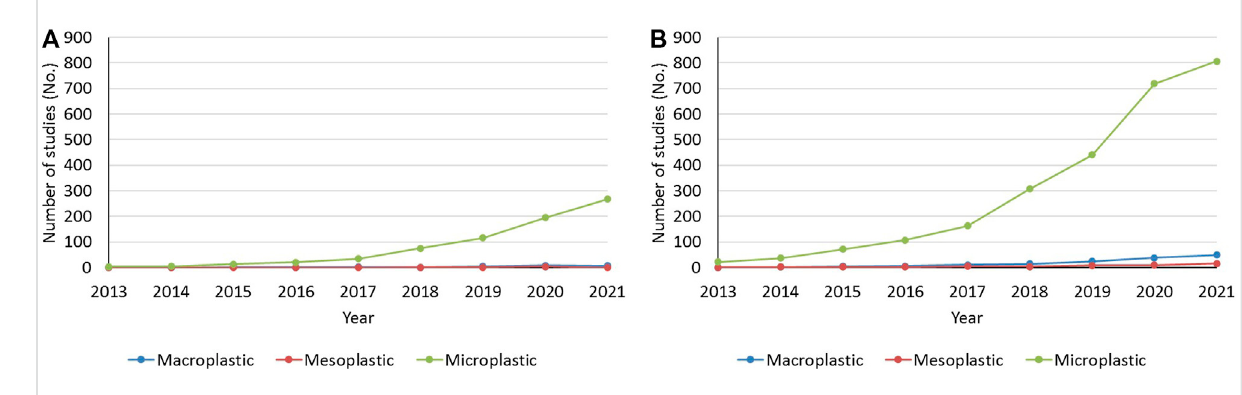
FIGURE 2 Number of studies (No.) for (A) freshwater and (B) marine macro-, meso- and microplastics.